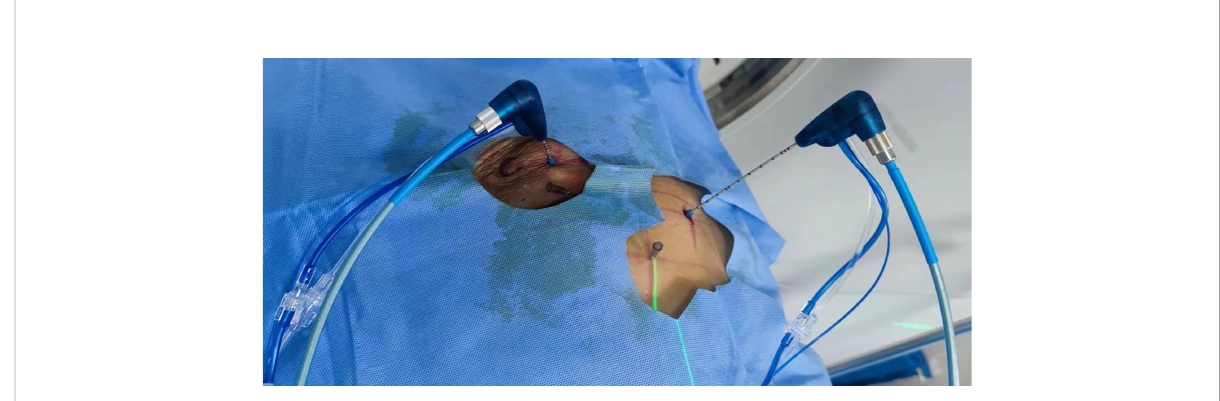
FIGURE 1 CT-guided microwave ablations of lung